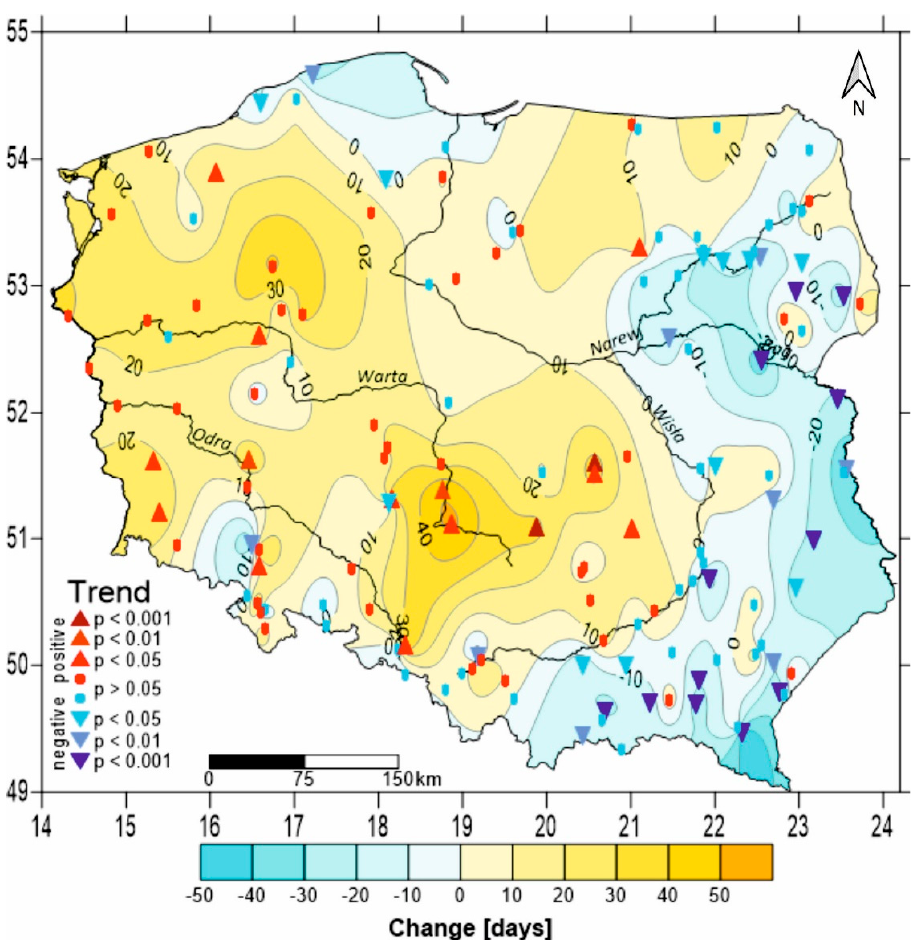
Figure 13. Spatial distribution of changes in ND LF between 1988–2020 (after climate change) and 1951–1988 (before climate change in 1987–1989) and trends of changes in 1951–2020 with their statistical significance ( p ).